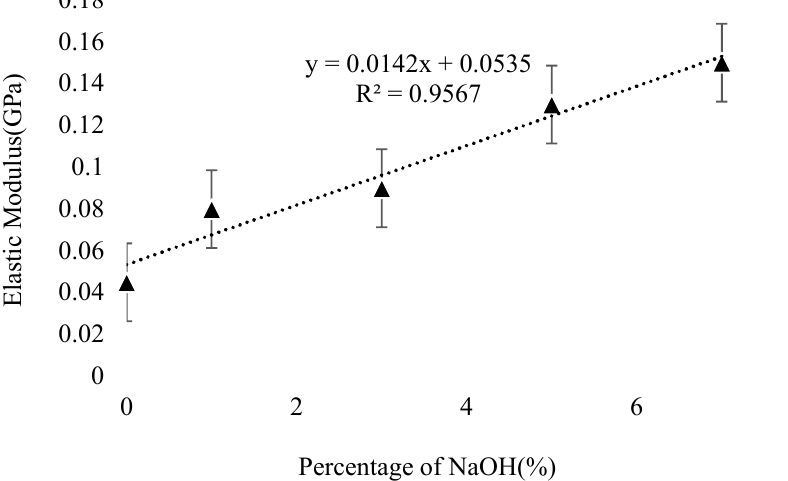
Figure 18. E ff ect of NaOH content on elastic modulus, adopted from [147]; Elsevier, 2016. Figure 18. Effect of NaOH content on elastic modulus, adopted from [147]; Elsevier, 2016.